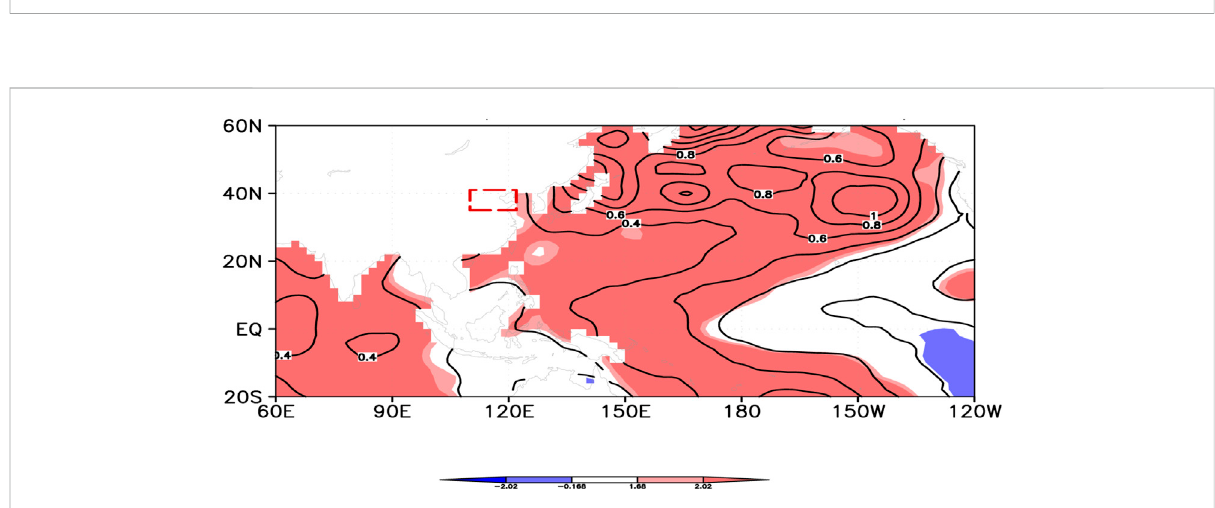
FIGURE 5 The same as Figure 3, but for the difference of SST during the periods 2004 – 2021 and 1979 – 2003 in the Paci fi c (unit: ° C). Shaded areas show differences reaching 90% and 95% con fi dence levels according to Student ’ s t -test. The box shows the region of North